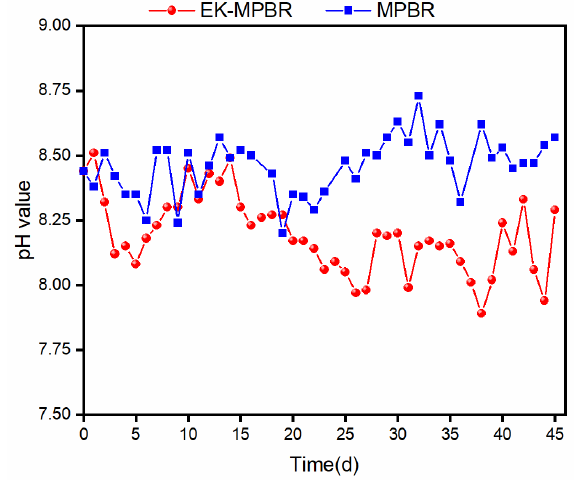
Figure 5. pH variation during EK-MPBR and MPBR operations.